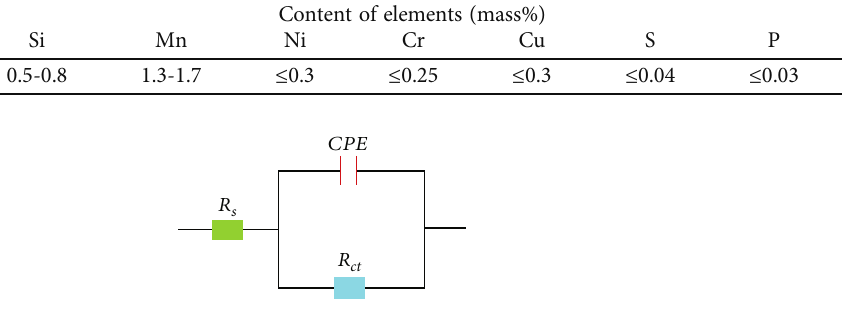
Figure 2: The equivalent electrical circuit for fi tting EIS spectra.